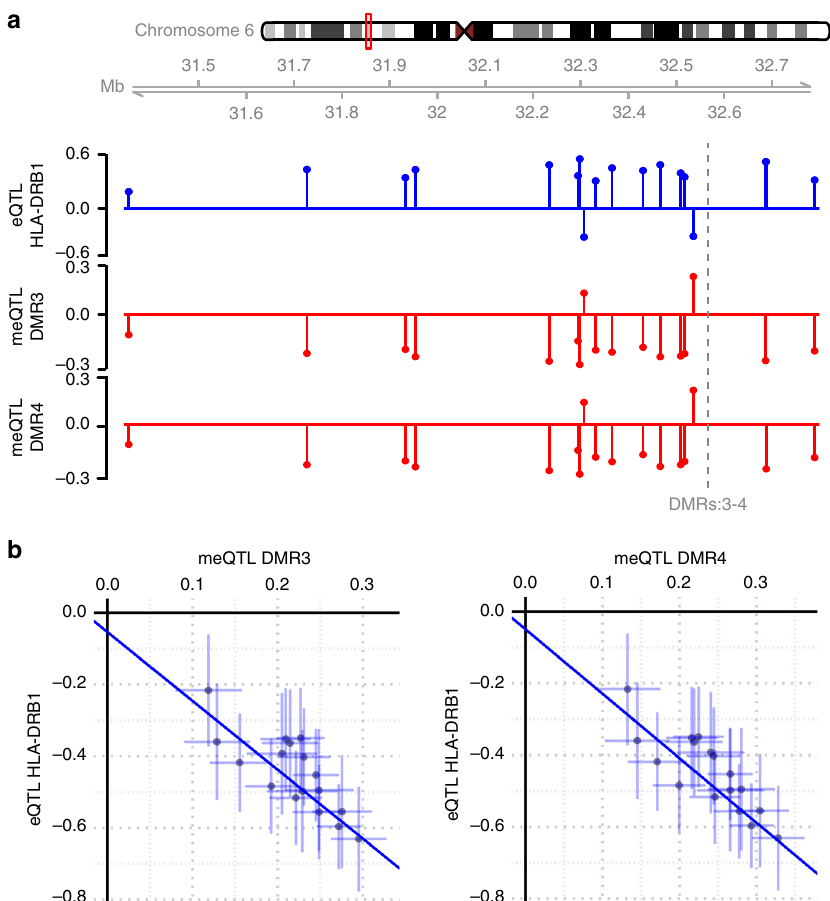
Fig. 5 Two-sample Mendelian randomization (MR). a The top plot shows the effect size from the eQTL analysis (outcome, n = 156, blue) in the PBMC cohort for the SNPs included in the MR. The middle and bottom plots (red) show the effect sizes from the meQTL analysis (exposure, n = 279, red) in the blood cohort for DMR3 and DMR4, respectively, for the SNPs included in the MR. The location of two regions is marked with a dashed line. Further details are given in Methods. b Scatterplots of the effect sizes for meQTL ( x- axis) and eQTL ( y -axis) for DMR3 (left) and DMR4 (right). The effect size and the 95% con fi dence intervals are shown. The blue line represents the causal estimate using the Egger regression. All the associations with the exposures were set to be positive and the associations with the outcome were